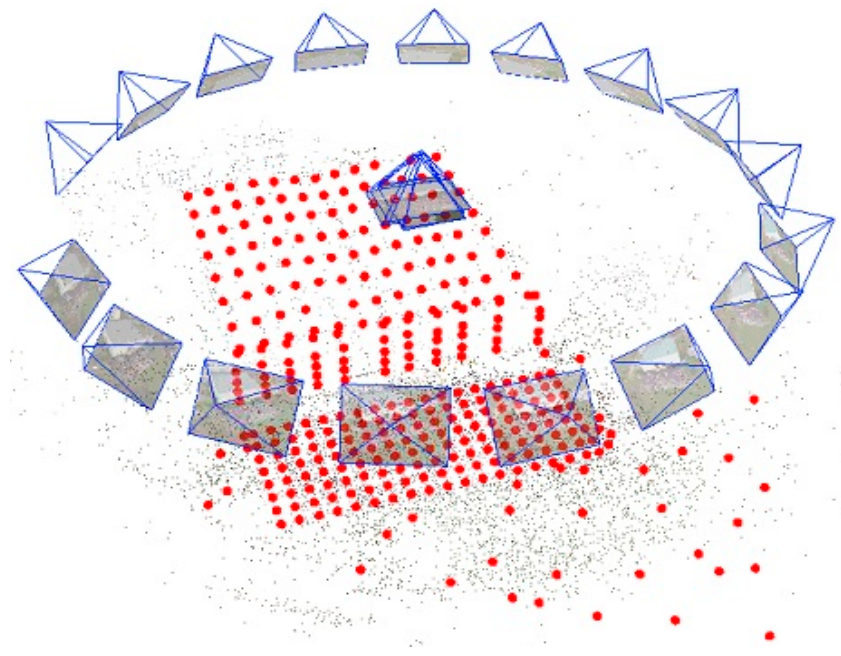
Figure 11. The elements resulted after the bundle adjustment process: cameras positions and orientations, GCPs positions and sparse point cloud.